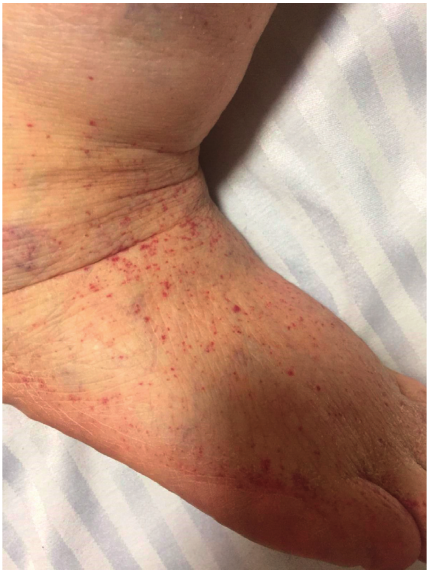
Figure 2: Janeway lesions: a sign of septic